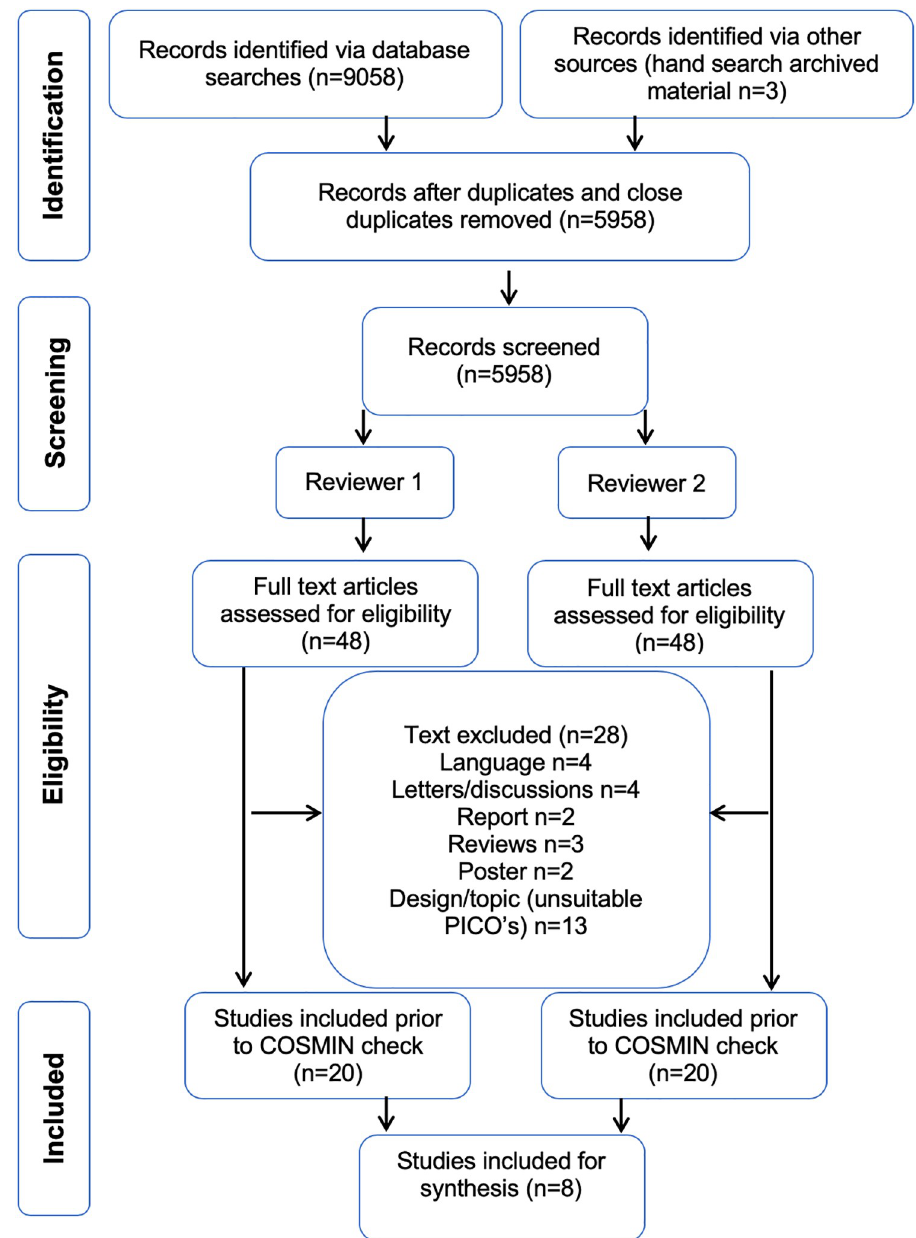
Fig 1. Flow diagram based on the PRISMA statement [30] illustrating the identification and selection process for the study retrieval.